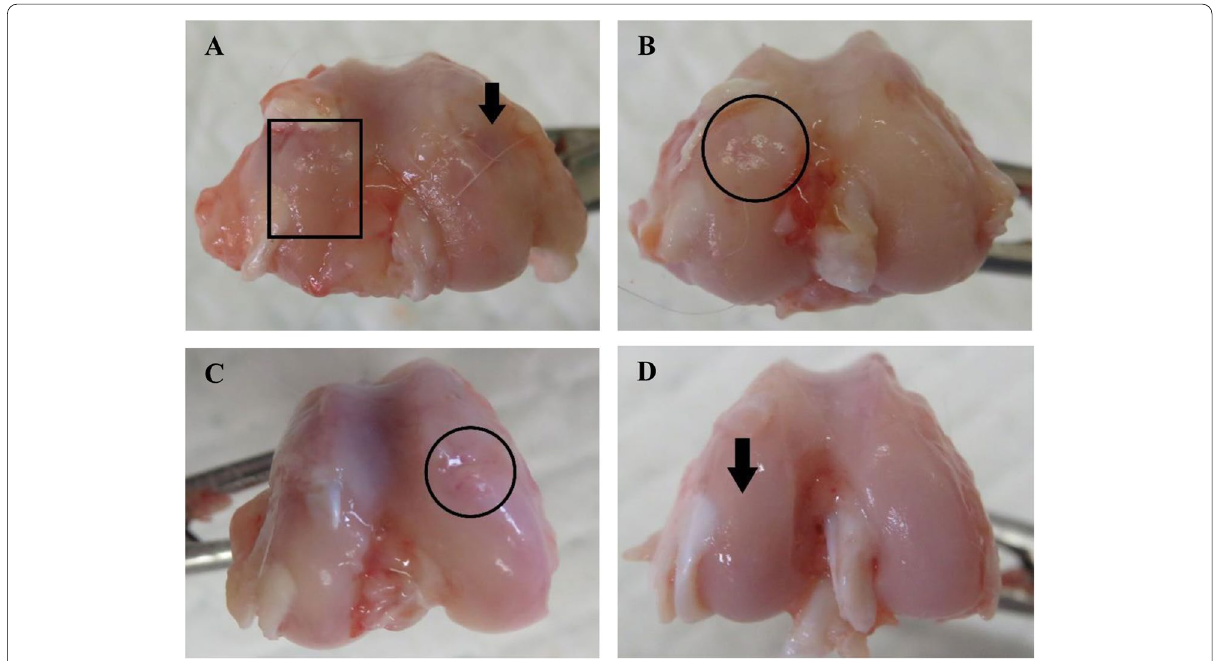
Fig. 1 Macroscopic appearance of the cartilage. A Ulceration and erosions on cartilage in control group. B Cartilage fibrillation in GH1 group. C Cartilage fibrillation in GH3 group. D Near-normal cartilage in GH5 group